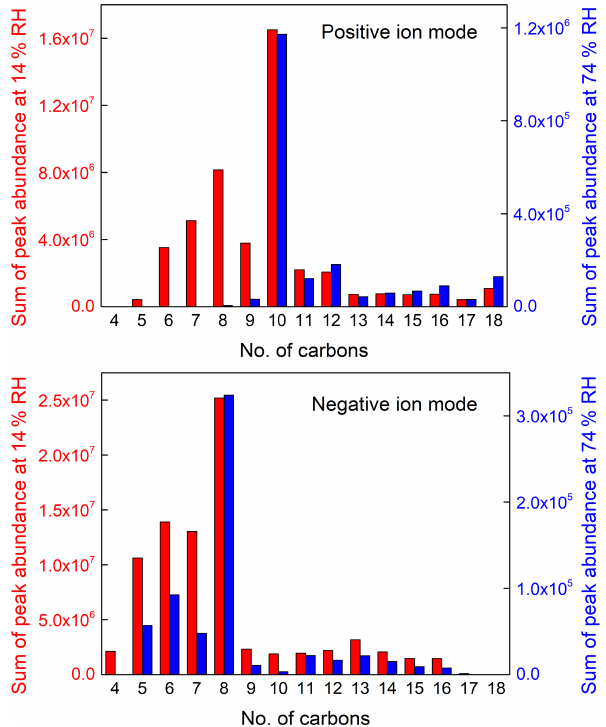
Figure 5. Sum of peak abundance based on peaks selected in Fig. 4 as a function of the number of carbon atoms under the positive ion mode and negative ion mode (note that the y axis scale at low and high RH are largely different, with a label step of 4 . 0 × 10 6 at low RH and 4 . 0 × 10 5 at high RH in the positive ion mode, and 5 . 0 × 10 6 at low RH and 1 . 0 × 10 5 at high RH in the negative ion